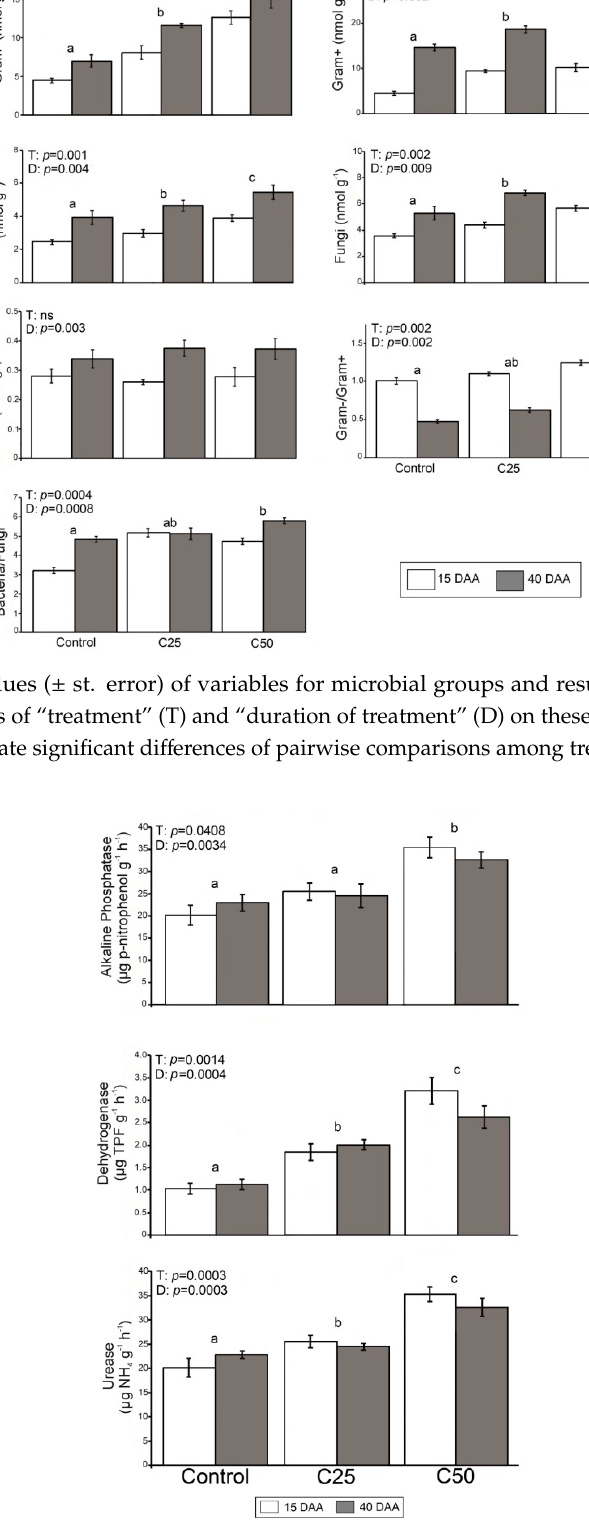
Figure 2. Mean values (± st. error) of soil enzyme activities and results of PERMANOVA regarding the effect of “treatment” (T), “duration of treatment” (D) on these parameters. Different letters (a, b, c) indicate significant differences of pairwise comparisons among treatments (Control, C 25 and C 50 ).